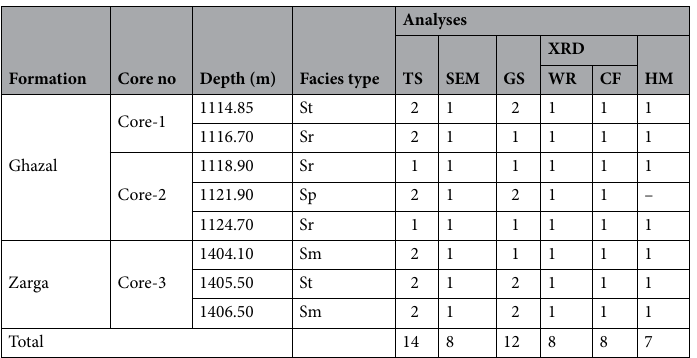
Table 2. Details of analysis carried out on the studied core samples. All depth references are core depths. TS thin section analysis, SEM scanning electron microscopy, GS grain-size analysis, XRD (WR) X-ray diffraction analysis of the whole rock, XRD (CF) X-ray diffraction analysis of < 2 micron clay fraction, HM heavy mineral analysis.